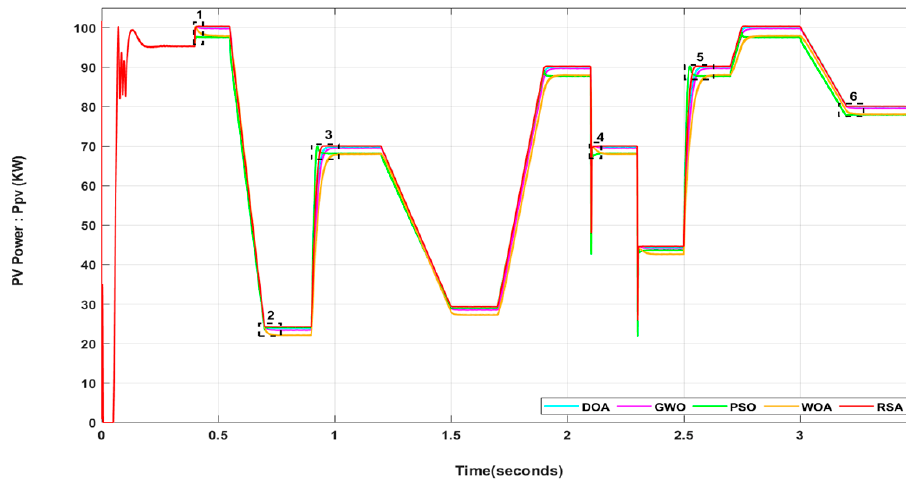
Figure 5. PV output power (P pv ) under USI condition.